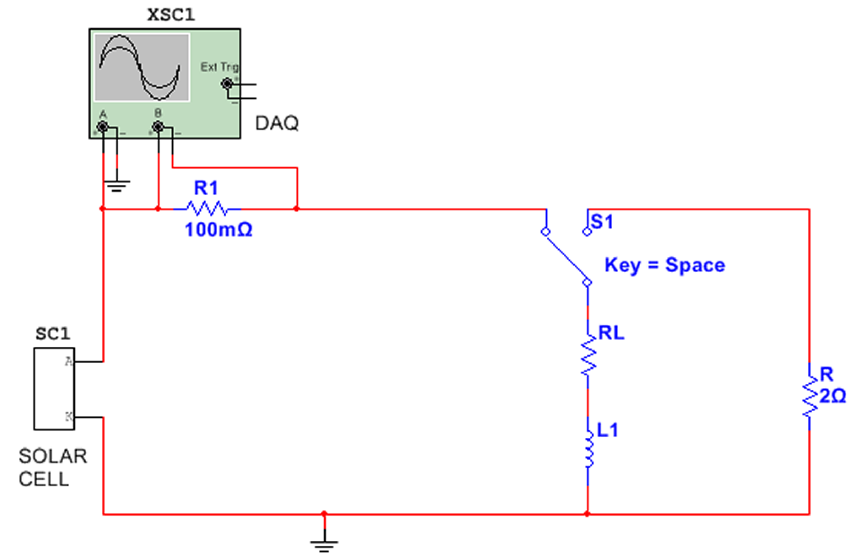
Figure 4. The electrical circuit used to study the AC solar cell parameters.